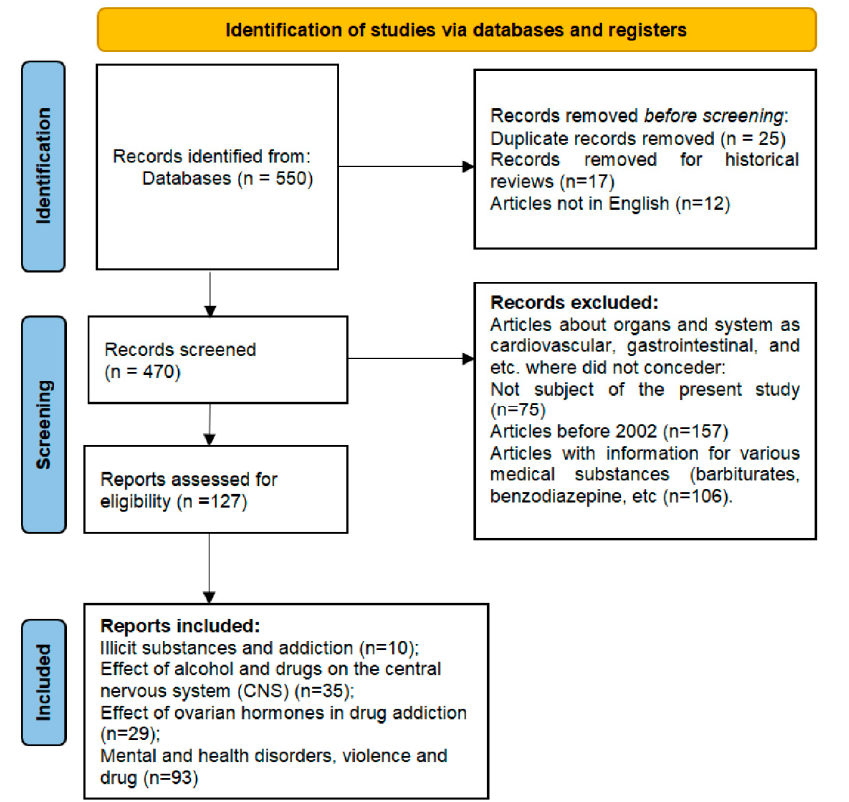
Figure 1. Comprehensive literature search strategy according to the chosen topic: inclusion and exclusion